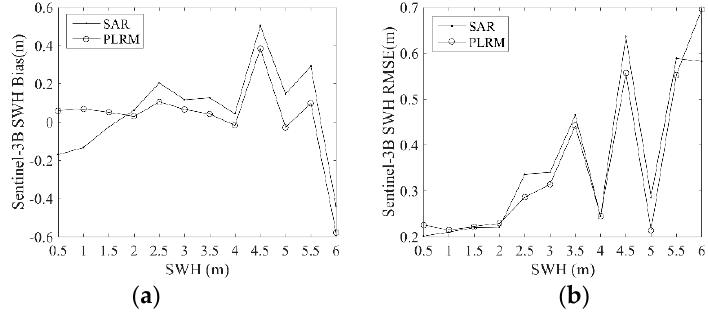
Figure 12. Dependence of ( a ) bias and ( b ) RMSE of Sentinel-3B SWH on buoy wave height.